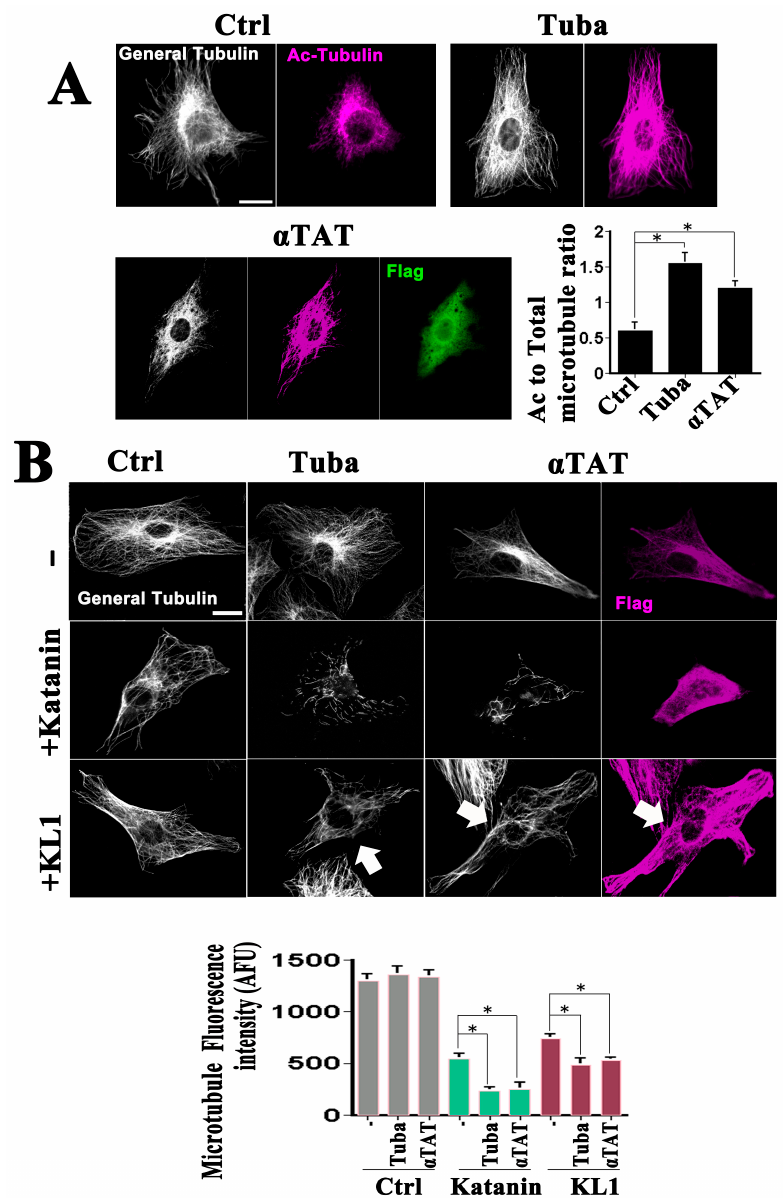
Figure 1. Effects of enhanced microtubule acetylation on KL1-mediated microtubule severing in RFL-6 cells. ( A ) Effects of tubacin treatment and flag-tagged α -TAT1 overexpression on cellular microtubule acetylation in RFL-6 cells. Cells were treated with tubacin or transfected with flag-tagged α -TAT1 expression plasmids, cultured, and stained using anti-tubulin, anti-acetylated-tubulin, and anti-flag antibodies. In the immunofluorescence images, the white signals indicate general tubulin (General Tubulin), magenta denotes acetylated tubulin (Ac-Tubulin), and green signals indicate the expressed flag tag (Flag). Compared with the control cells (Ctrl), both the tubacin-treated cells (Tuba) and α -TAT1 overexpressing cells ( α TAT) showed enhanced microtubule acetylation. Scale bar, 10 µm. The graph shows the quantified acetylated-tubulin/total-tubulin signal ratios. Significant increases were detected between control vs. tubacin or control vs. α -TAT1. ( B ) Representative images of the